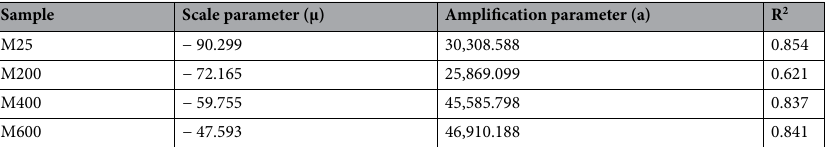
Sample Scale parameter